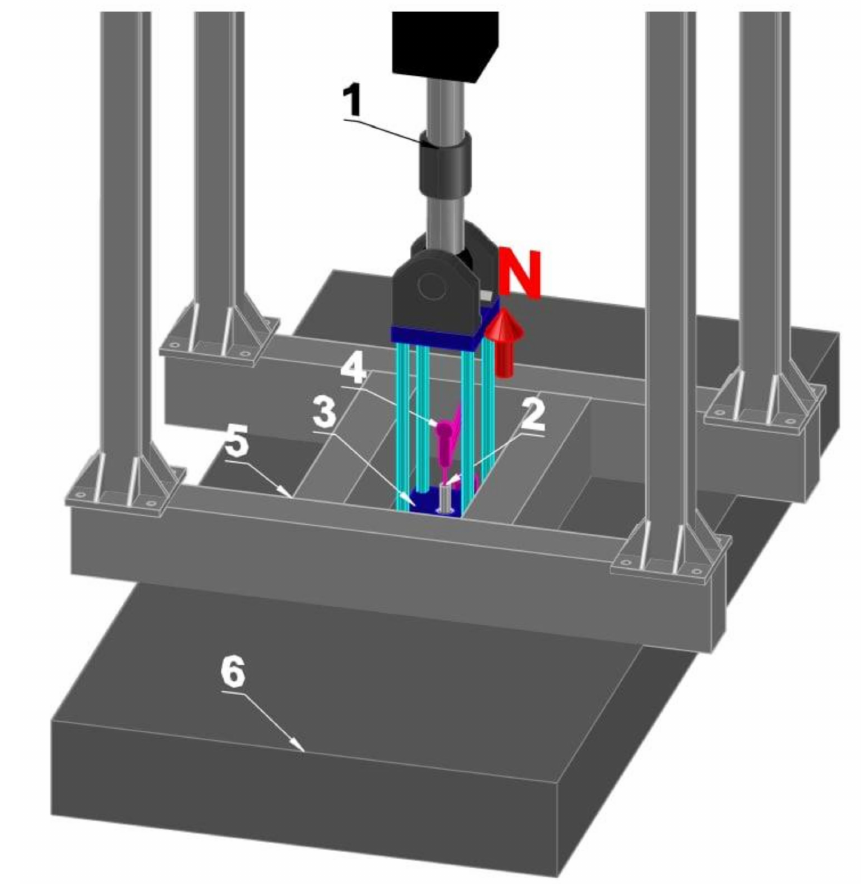
Figure 6. The anchor loading pattern applied in the experimental studies: 1—hydraulic cylinder, 2—anchor, 3 –element to be fastened, 4—displacement sensor, 5—loading frame, 6—concrete base, N—pullout